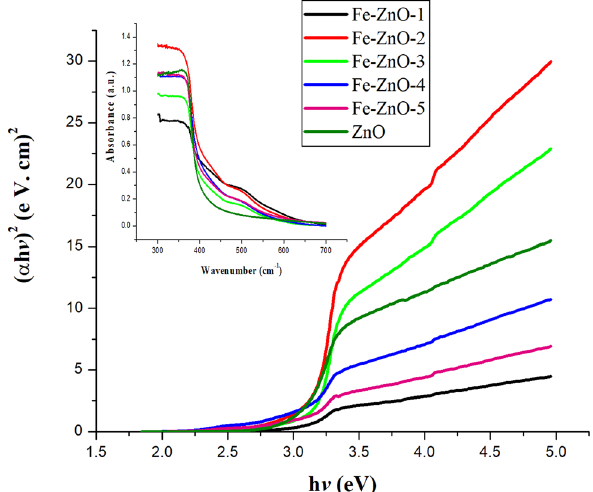
Figure 6: Optical band gab of undoped ZnO and Fe – doped ZnO nanoparticles with di ff erent Fe contents ( 0.1 – 5.0 wt% )